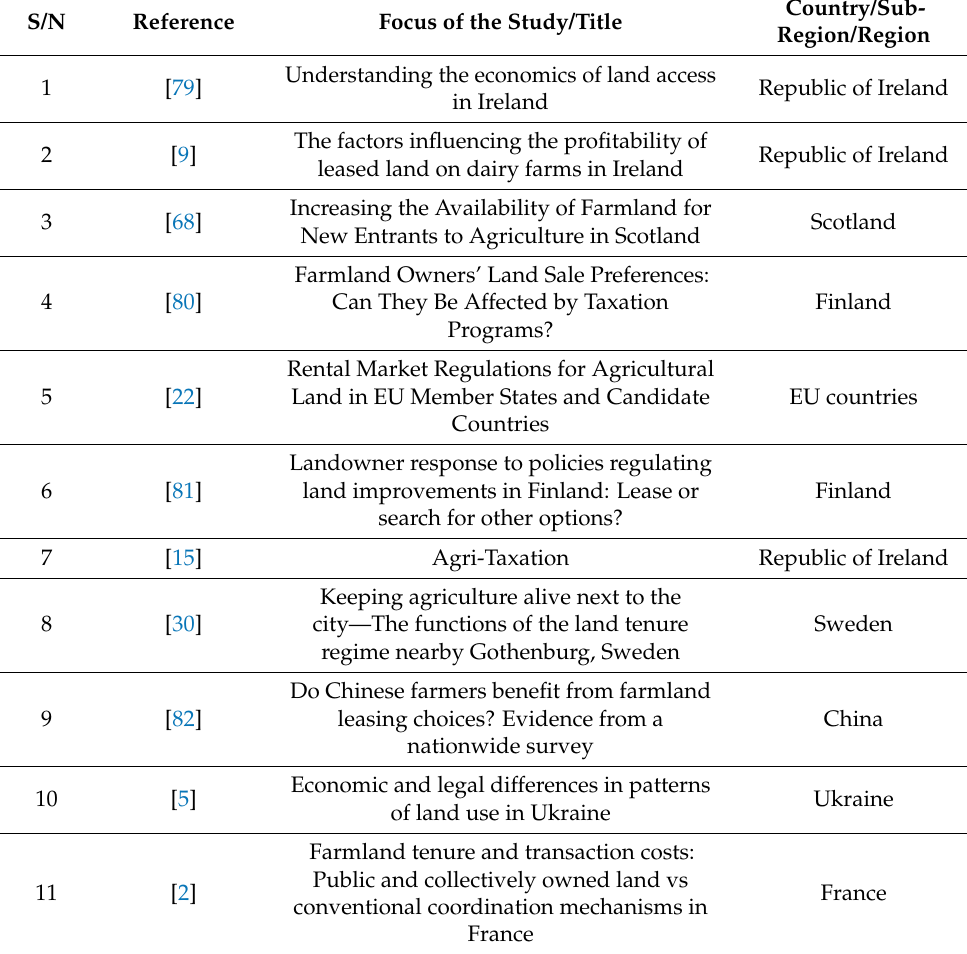
Table A1. Themes and papers associated with each theme in